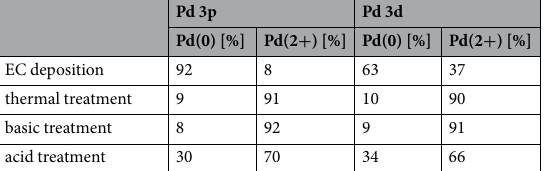
Table 1. Contents of Pd(0) and Pd(2 + ) measured by XPS, Fig. 4, at the surface of PdO/Pd/Au/Ti/SiO 2 /Si electrodes after electrochemical deposition of Pd layer, thermal treatment at 150 °C during 4 h and acid (0.1 M HCl) or basic (0.1 M NaOH) treatment during 12 h.